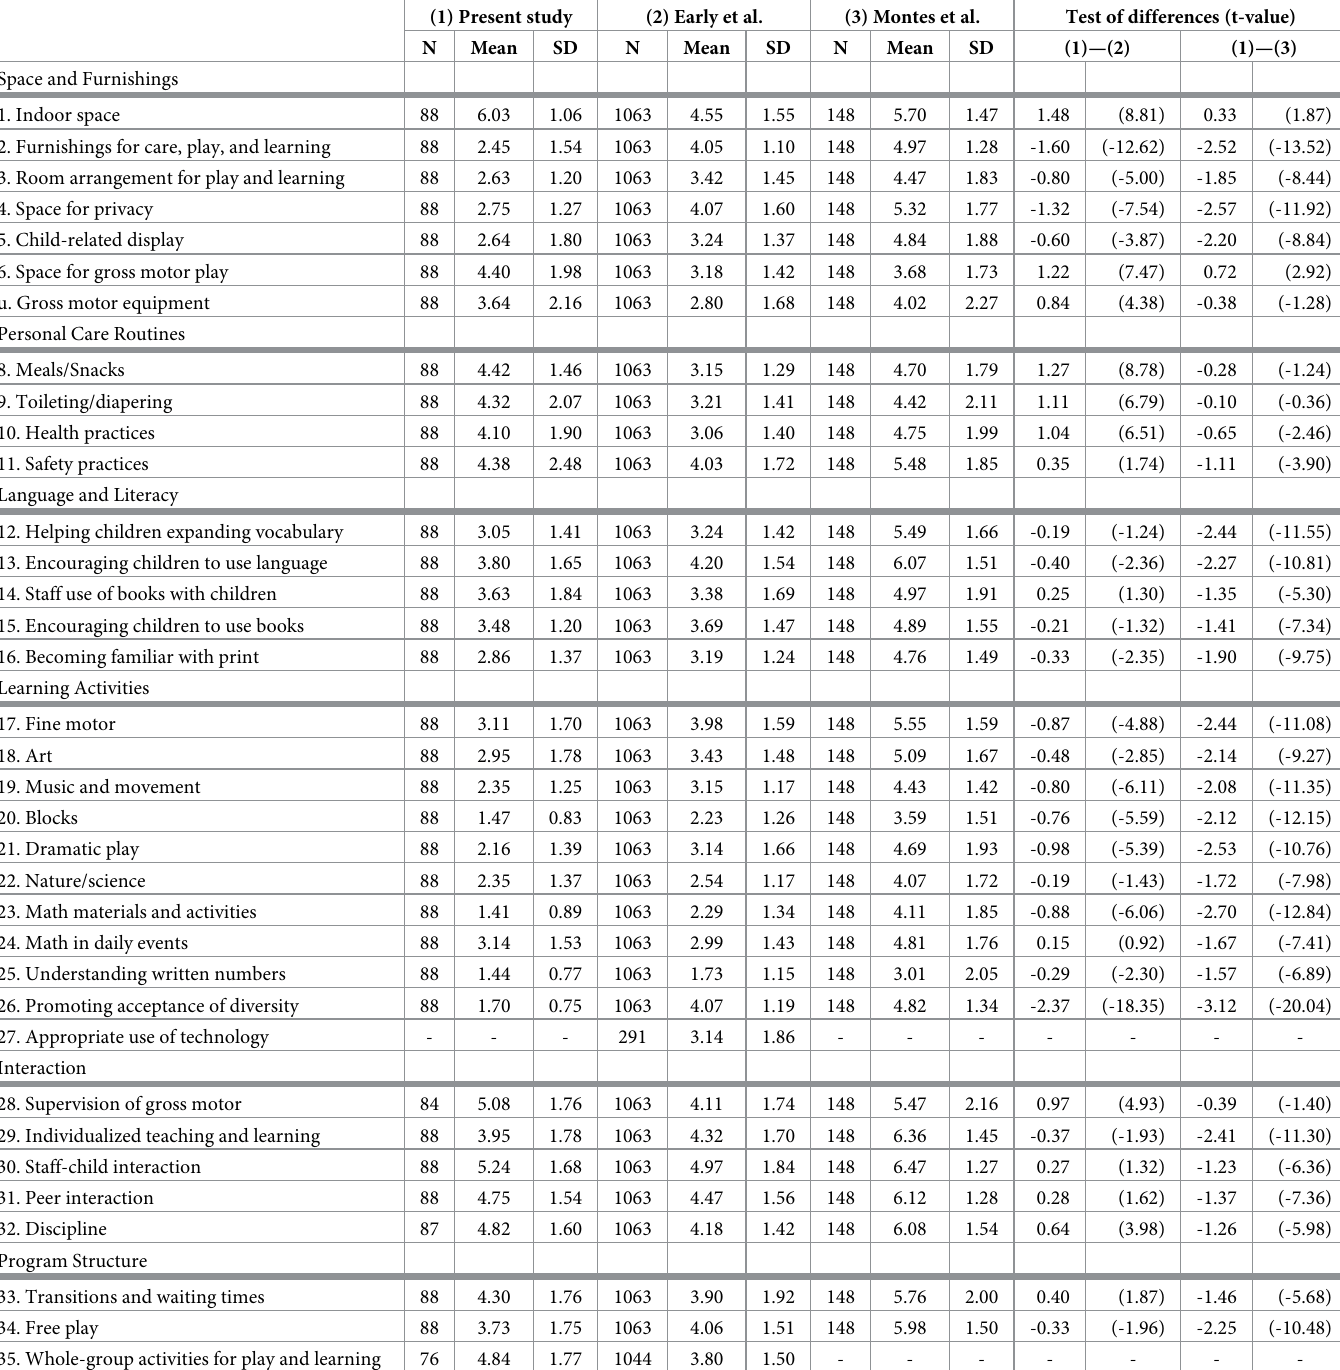
Table 7. Comparison of the ECERS-3 item scores among the three